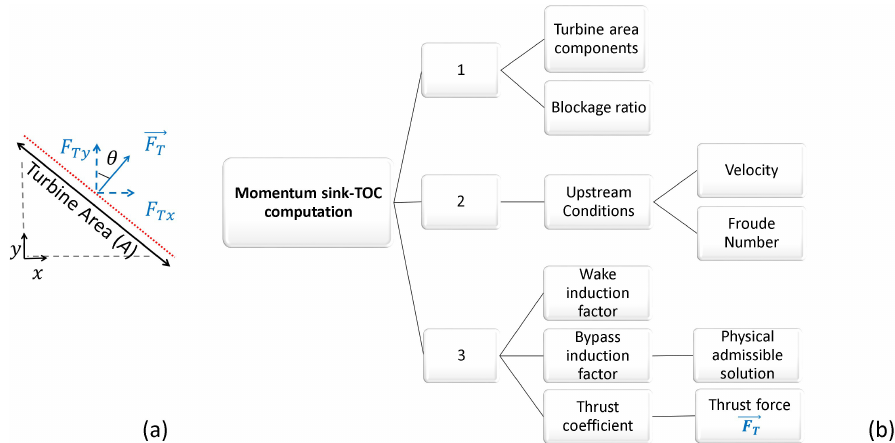
Figure 1. Two-dimensional representation of the thrust force ( (cid:126) F T ) exerted by the turbine to the incident tidal-stream ( a ) and the momentum sink turbine operating conditions (TOC) computation procedure ( b